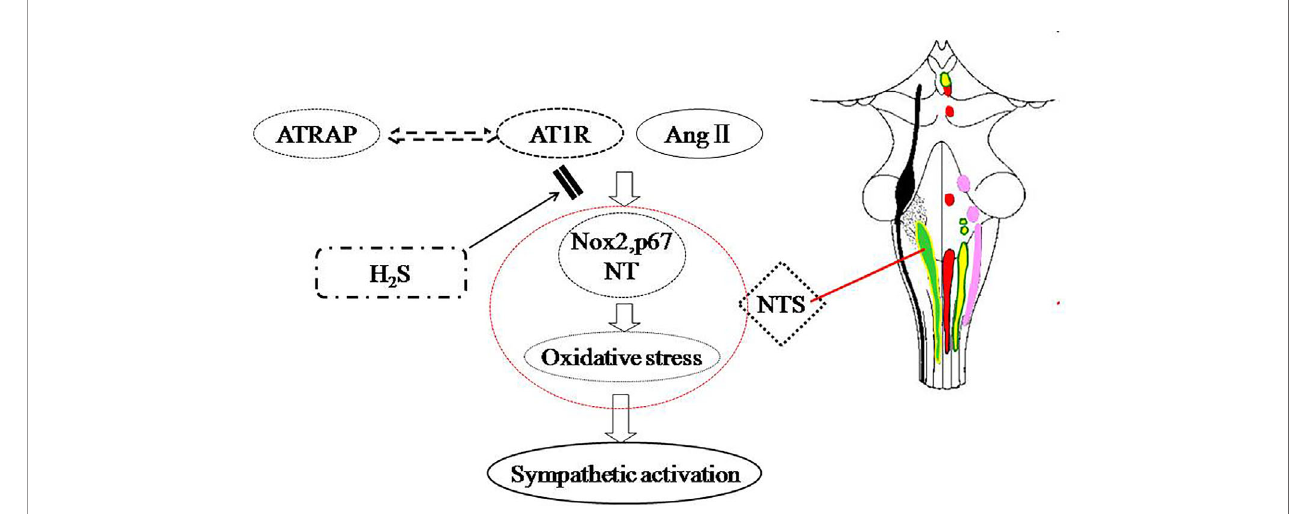
FIGURE 7 | Schematic representation of the ameliorative effect of H 2 S on sympathetic activation in offspring of parental